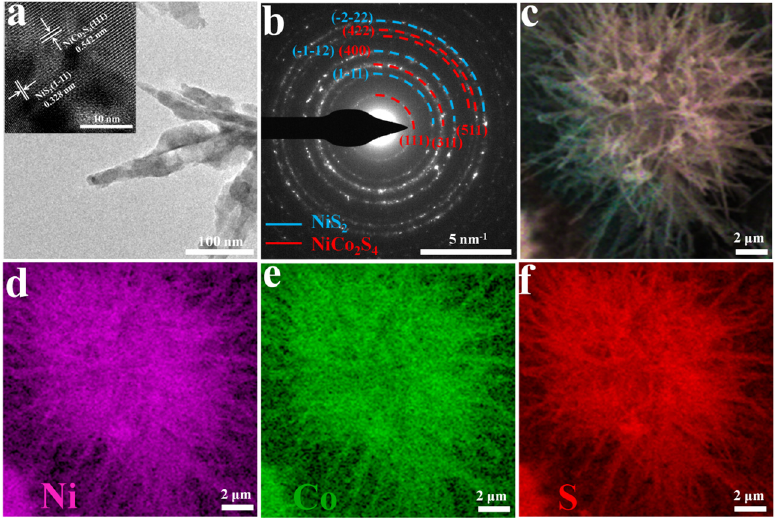
Figure 4. ( a ) The TEM image of NiCo 2 S 4 -NiS 2 , the inset is HRTEM image of NiCo 2 S 4 -NiS 2 . ( b ) Selected area electron diffraction (SAED) ring of NiCo 2 S 4 -NiS 2 . ( c – f ) The area chosen for EDX elemental mapping of Ni, Co and S, respectively.